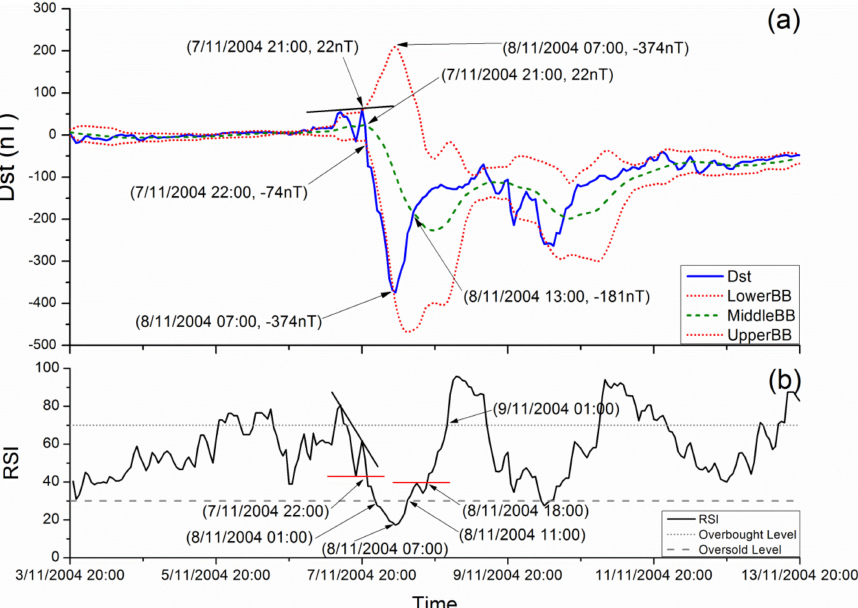
Figure 4. The evolution of an MS which occurred in 2004 in terms of ( a ) the SMA and Bollinger bands, and ( b ) the RSI indicator. The analyses results for a ten-day period from 3 November 2004 20:00 (UT) to 13 November 2004 20:00 (UT) are presented. The exact time and D st value for which specific features were found are marked on the figure using